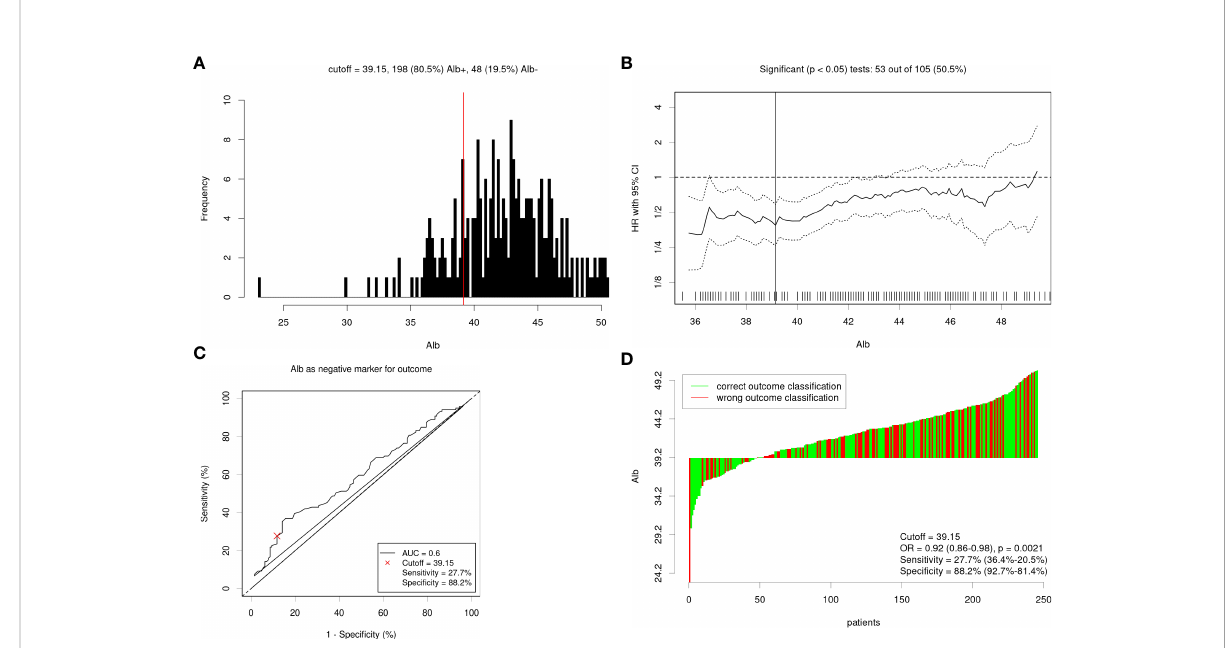
FIGURE 1 (A) Distribution based cutoff optimization (independent of outcome and survival data) in the OPC data. (B) Cutoff optimization by correlation with a binary variable (ALB<39.15 g/L; ALB ≥ 39.15 g/L) or survival in the OPC data. (C) Receiver operating characteristic curve for albumin levels predicting overall survival. (D) Detailed analysis of the optimal dichotomization of the OPC cancer